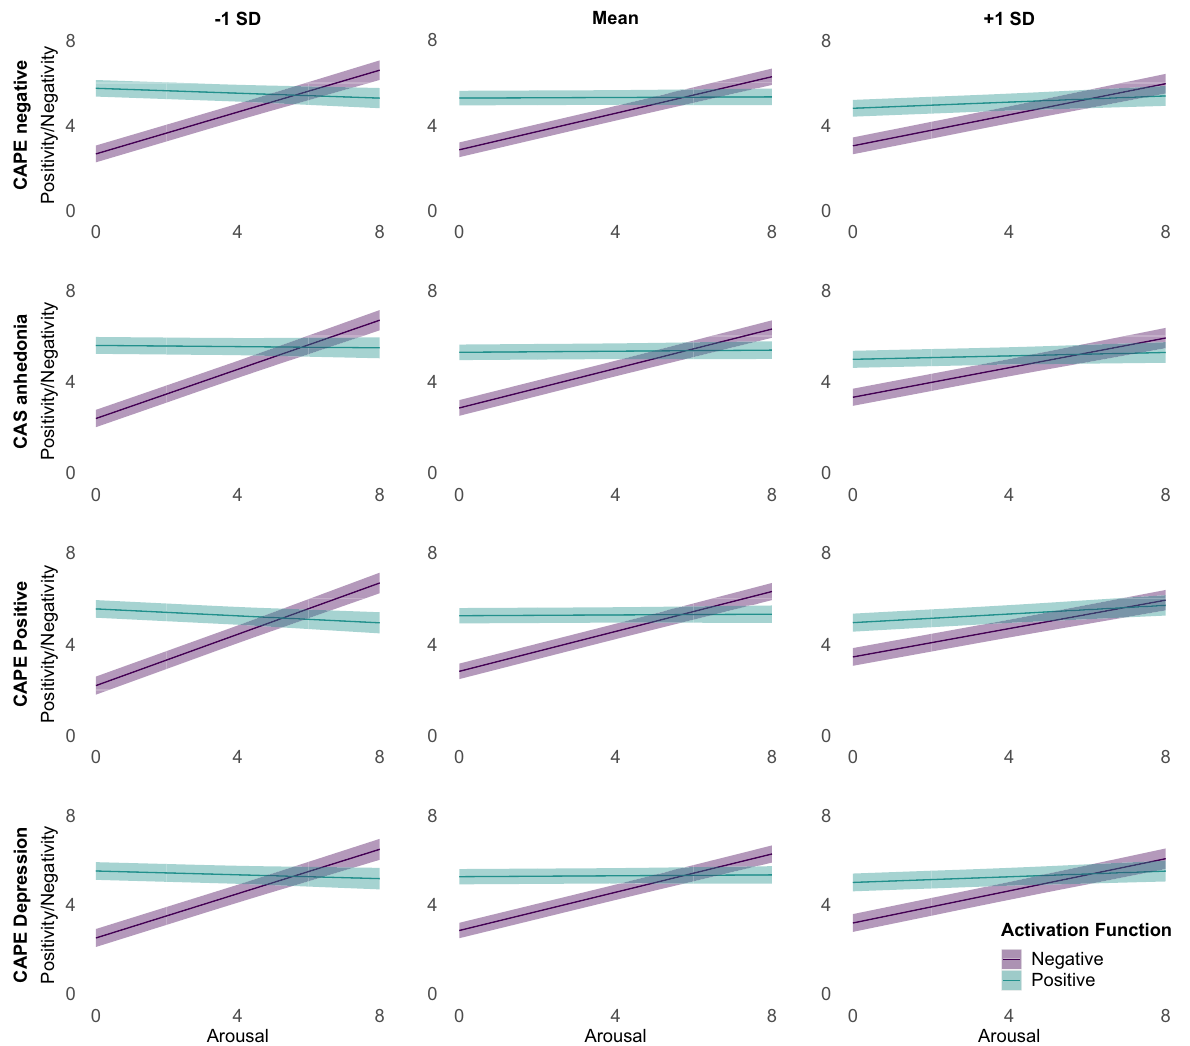
Fig. 3 Positivity and negativity activation functions estimated via MLM for different levels of the symptom measures. The shaded error bars represent the 95% CI